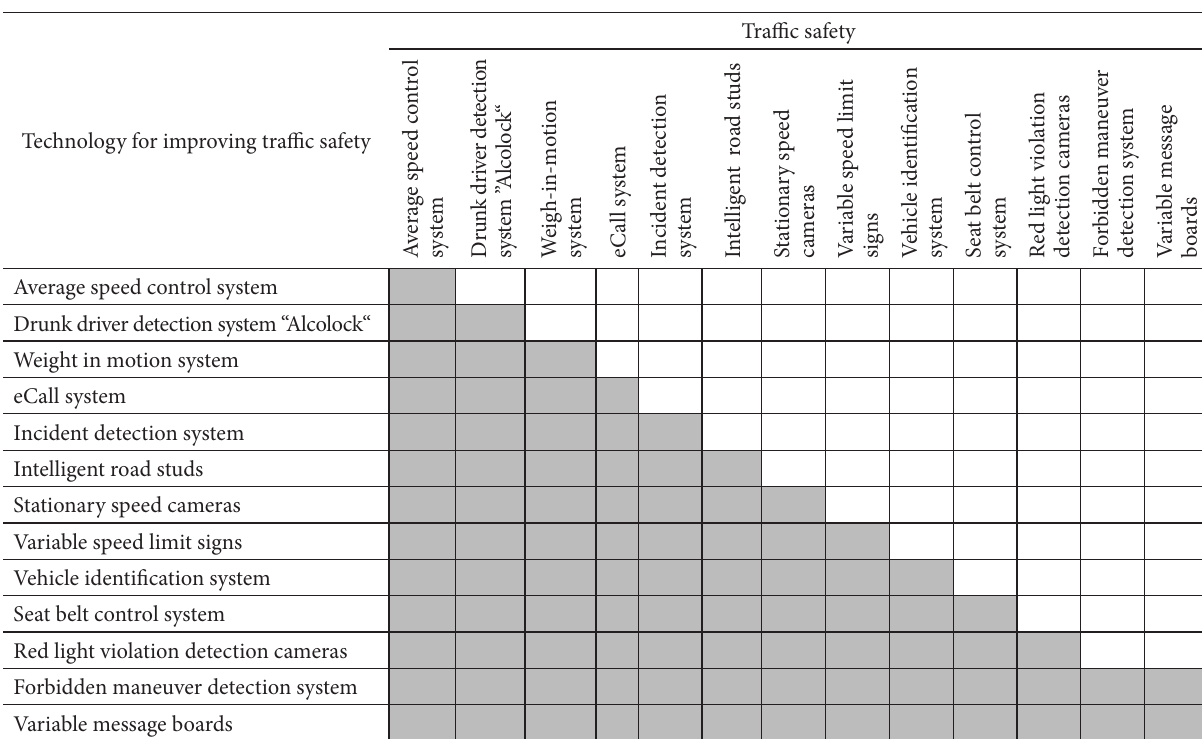
Table 2. Pairwise comparison of ITS and ITS applications